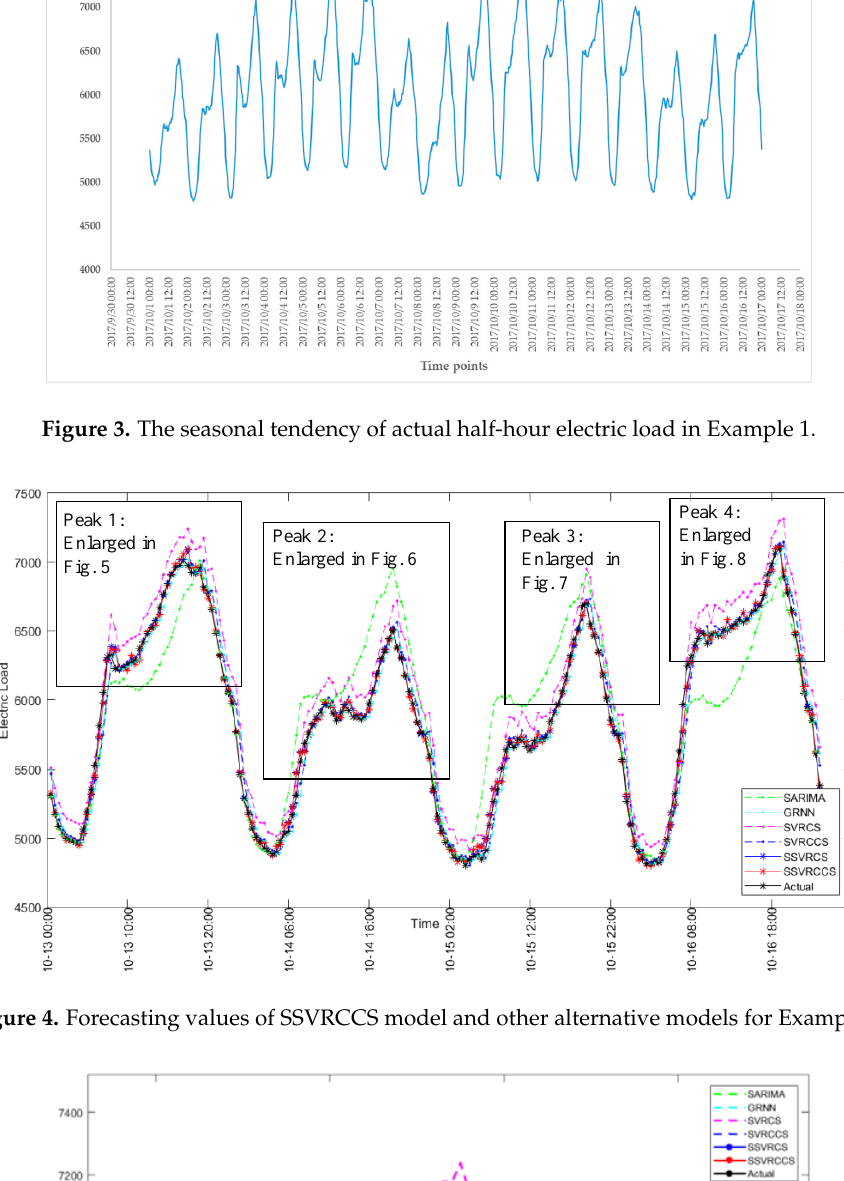
Figure 4. Forecasting values of SSVRCCS model and other alternative models for Example 1.